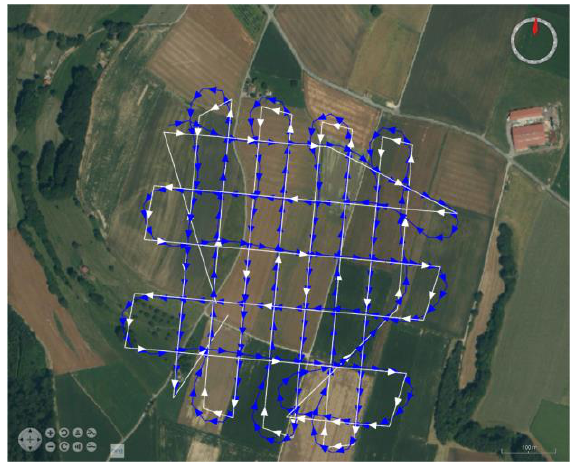
Figure 7: Post-mission analysis; blue path: the executed flight, white path: planned